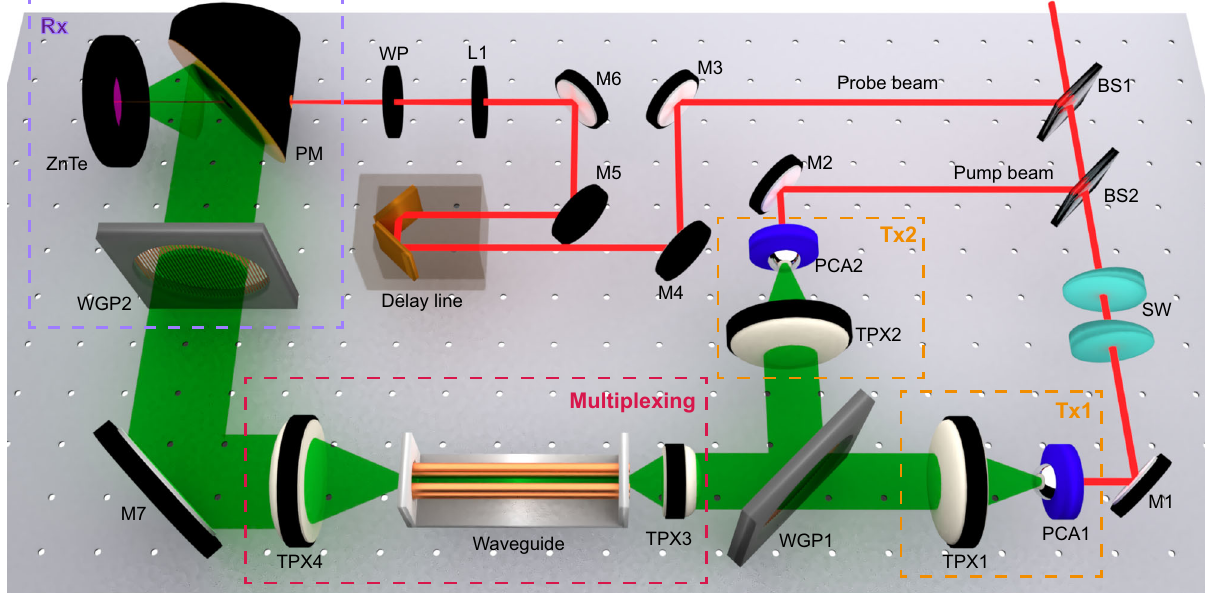
Fig. 3 Schematic of the experimental setup. For the demonstration of polarization-division multiplexing within the FWWG, two independent broadband transmitters (Tx1 and Tx2) and a single receiver (Rx) are employed. Two identical photoconductive antennas (PCAs) serve as transmitters, emitting a x - polarized THz beam in Tx1 and a y -polarized THz beam in Tx2. Two THz pulses are fi rst multiplexed in free-space via a wire-grid polarizer (WGP1), while mutual temporal coherence at the FWWG input is controlled by interposing two silica wedges (SWs) in the Tx1 arm. The orientation of WGP1 is set to 0°, resulting in the maximum transmission for Tx1 and maximum re fl ection for Tx2. The multiplexed THz pulses are then focused and coupled onto the 10 cm- long FWWG. After propagating through the waveguide, the two multiplexed THz pulses are guided towards the detection stage. Demultiplexing and detection are implemented by using another wire-grid polarizer (WGP2) and a standard electro-optic sampling technique in a ZnTe crystal, respectively. When the orientation of the WGP2 is set to 0°, the ZnTe crystal axis is rotated in such a way that only the x -polarized signal is recorded (con fi guration Rx1); by changing the WGP2 to the 90° position, and rotating the ZnTe crystal axis accordingly, only the y -polarized signal can be